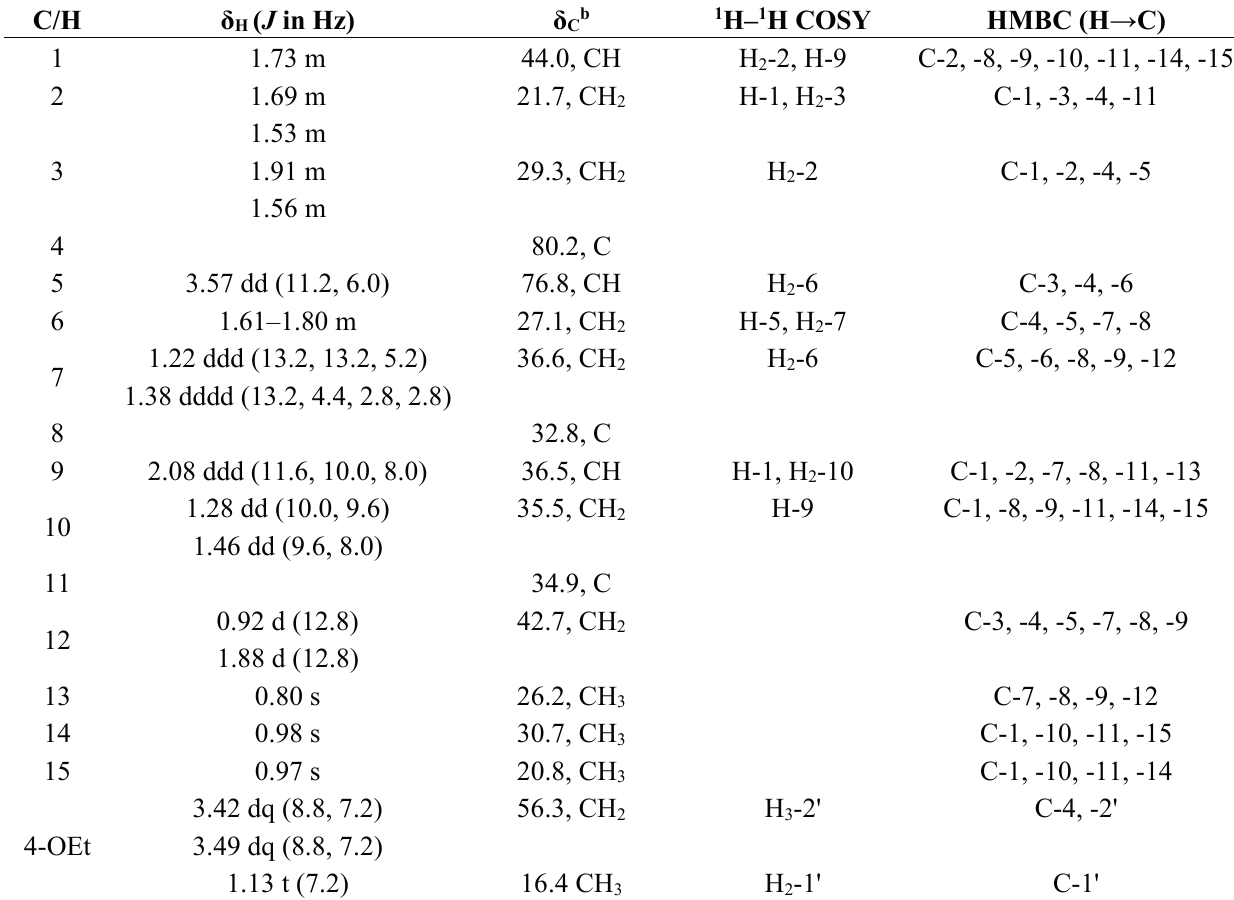
Table 2. 1 H and 13 C NMR data, 1 H– 1 H COSY and HMBC correlations for sesquiterpenoid 2 .